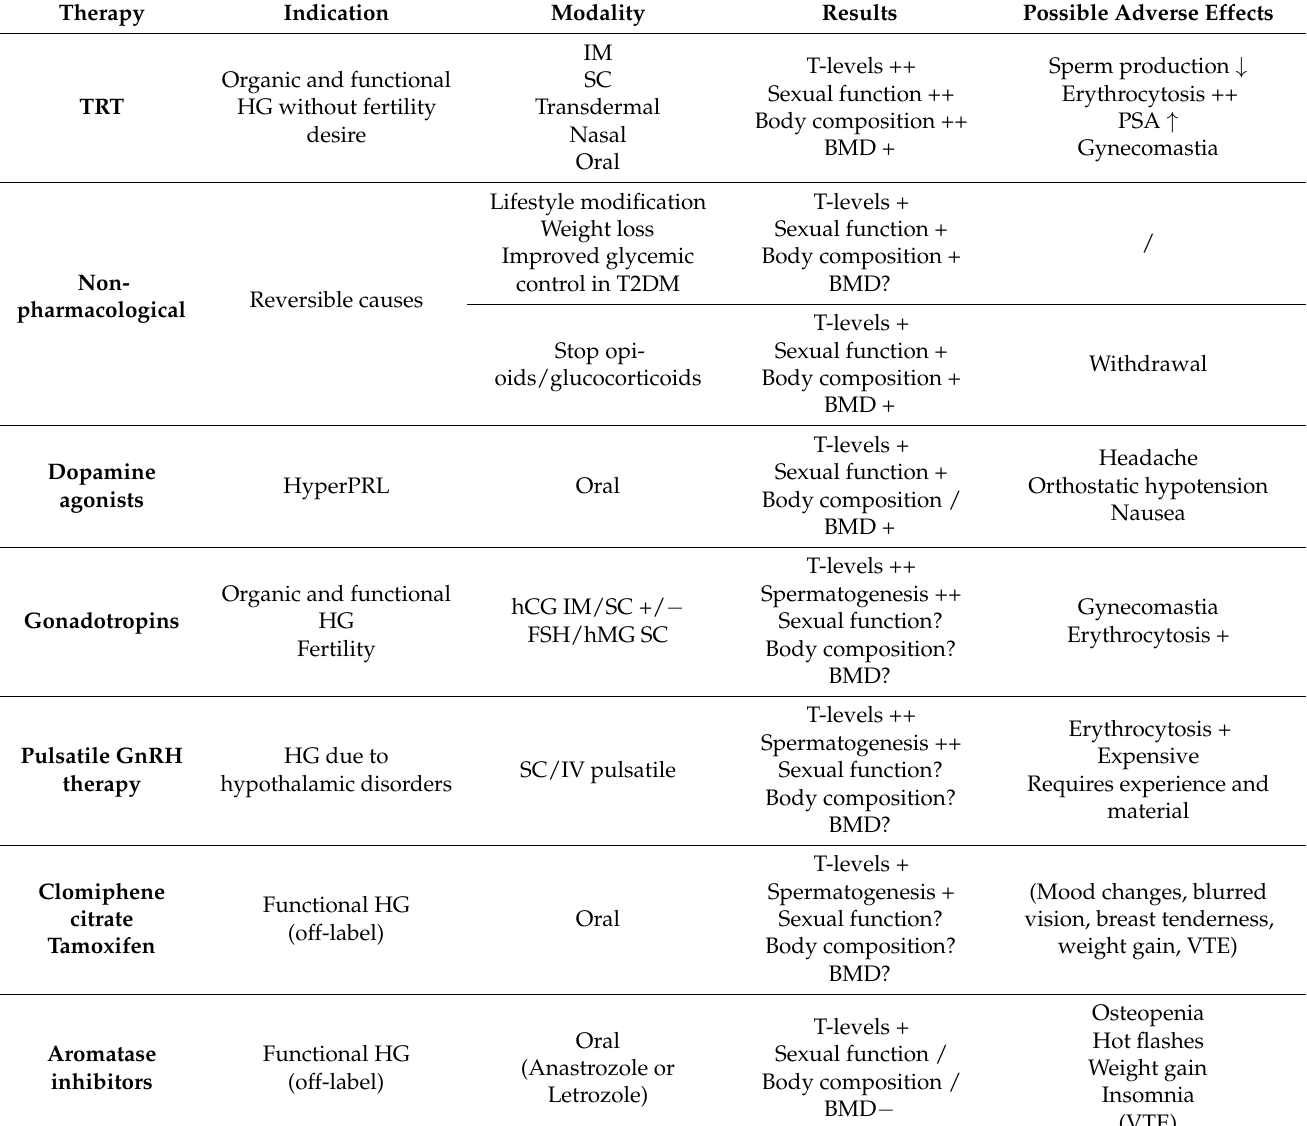
Table 1. Overview of the different treatment options in central